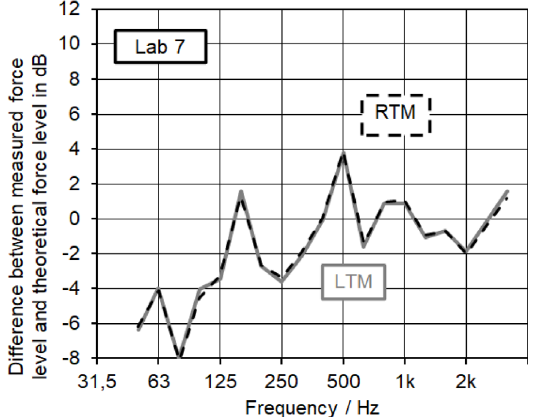
Figure 12. Difference between measured level of equivalent blocked force and theoretical value with T = 0.5 s and ffiffiffi p (cid:7) (cid:8) v 0 ¼ (cid:3) 1 v 2 for RTM and LTM in lab max max